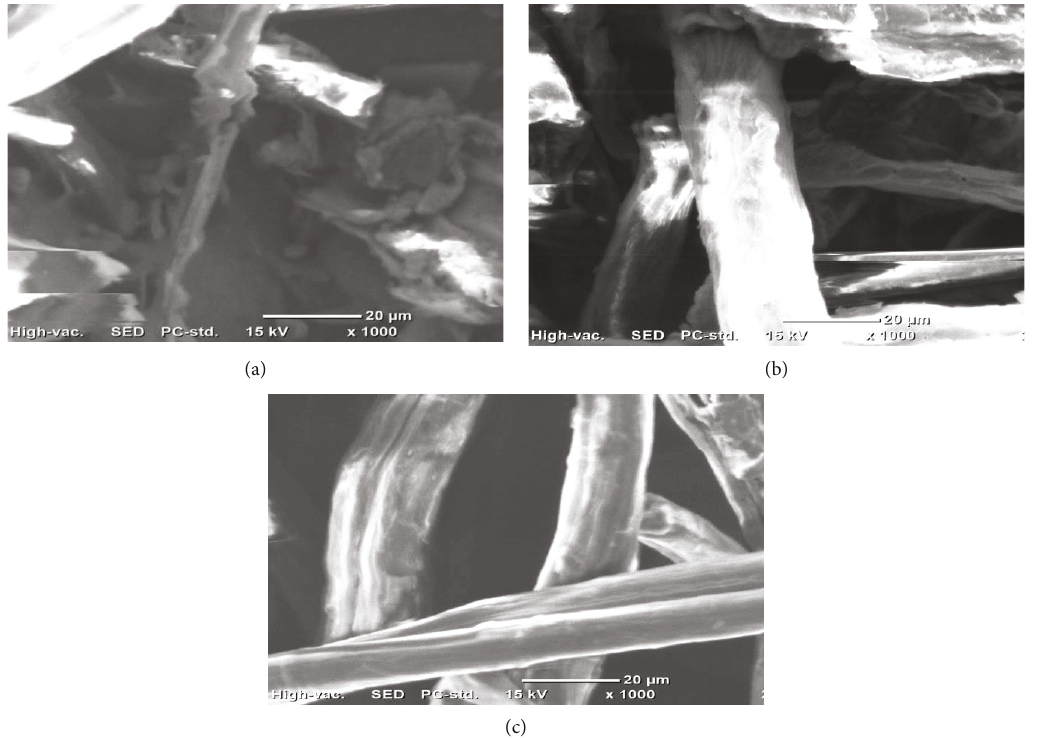
Figure 6: SEM image of ROA (a), AOA (b), and BOA